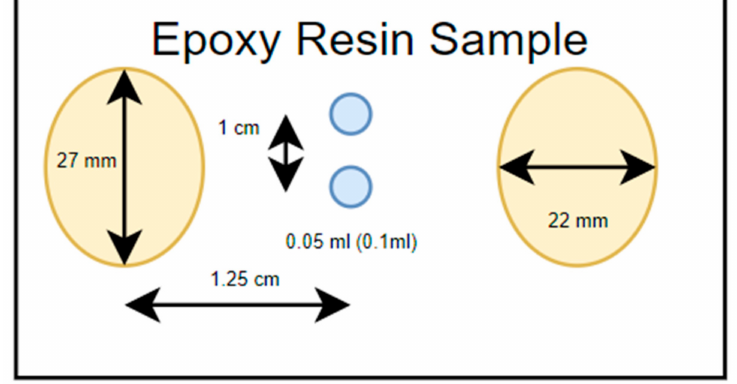
Figure 20. Two-Droplets Arrangement with one on top of the other (2.2D).